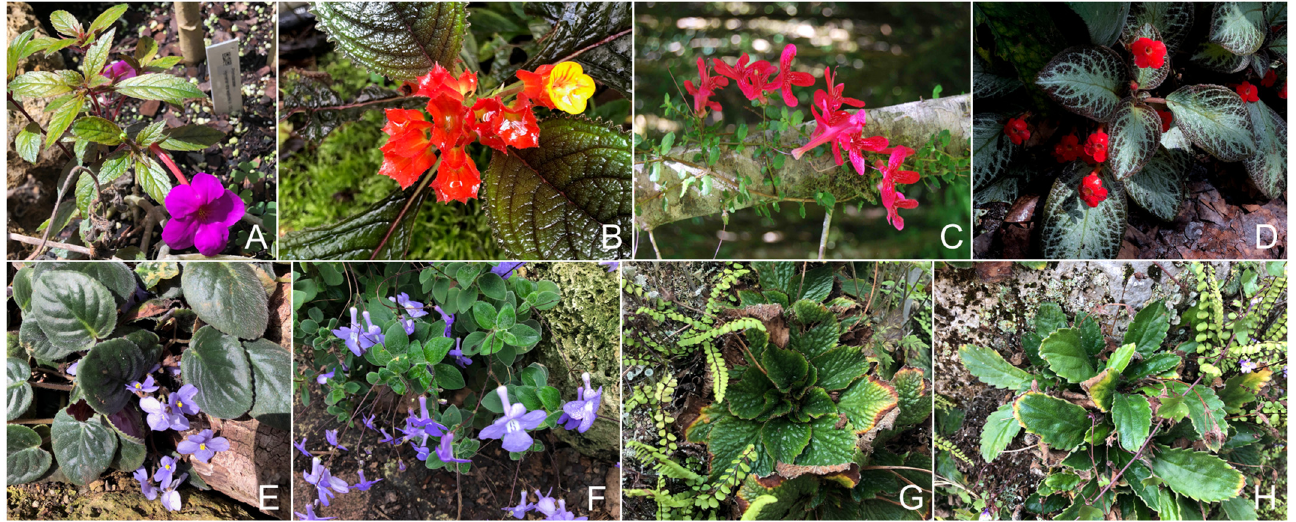
Figure 1. Examples of plants species from Gesnerioideae ( A – D ) and Didymocarpoideae ( E – H ): Achimenes sp. ( A ), Alloplectus sp. ( B ), Asteranthera ovata ( C ), Episcia sp. ( D ), Streptocarpus spp. ( E , F ), Ramonda myconi ( G ), and Haberlea rhodopensis ( H ).